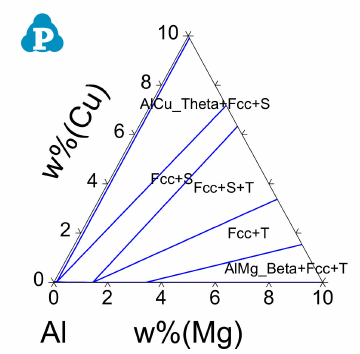
Figure 13. The isothermal section of Al-Cu-Mg alloy at 200 ◦ C calculated by Pandat